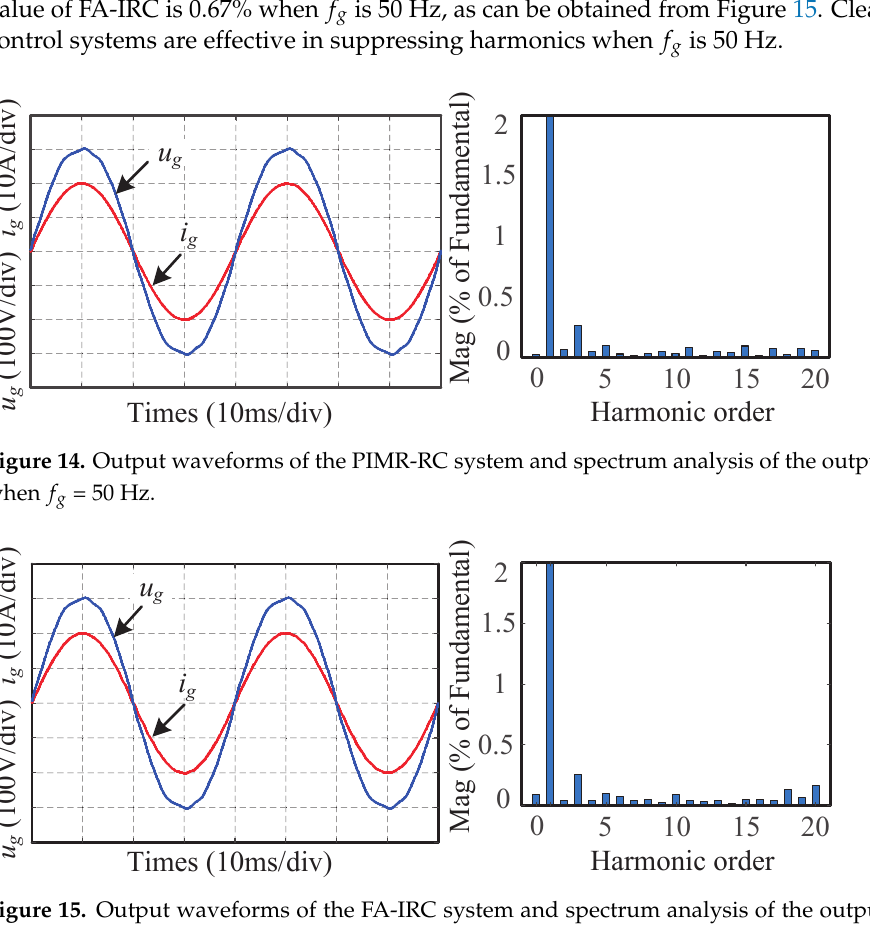
Figure 15. Output waveforms of the FA-IRC system and spectrum analysis of the output current when f g = 50 Hz.